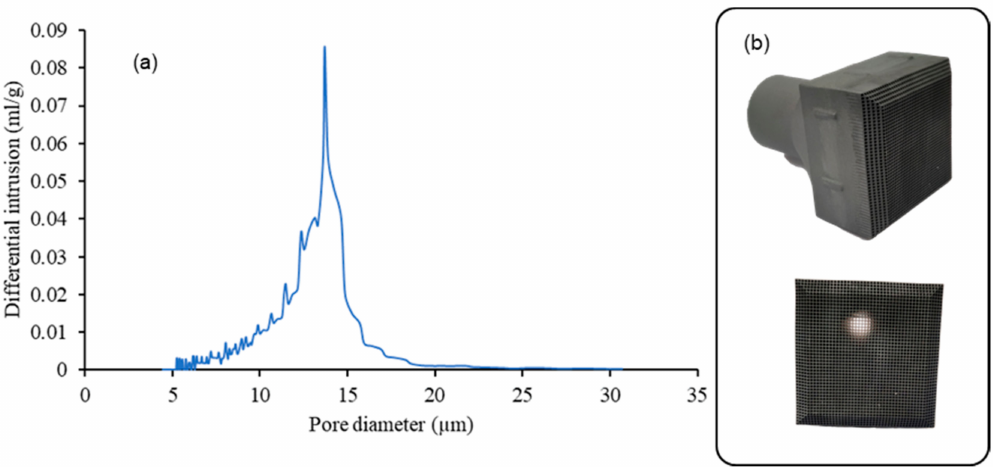
Figure 7. ( a ) Hg porosimetry of the monolith at T-100 ◦ C, ( b ) picture of an example of the final